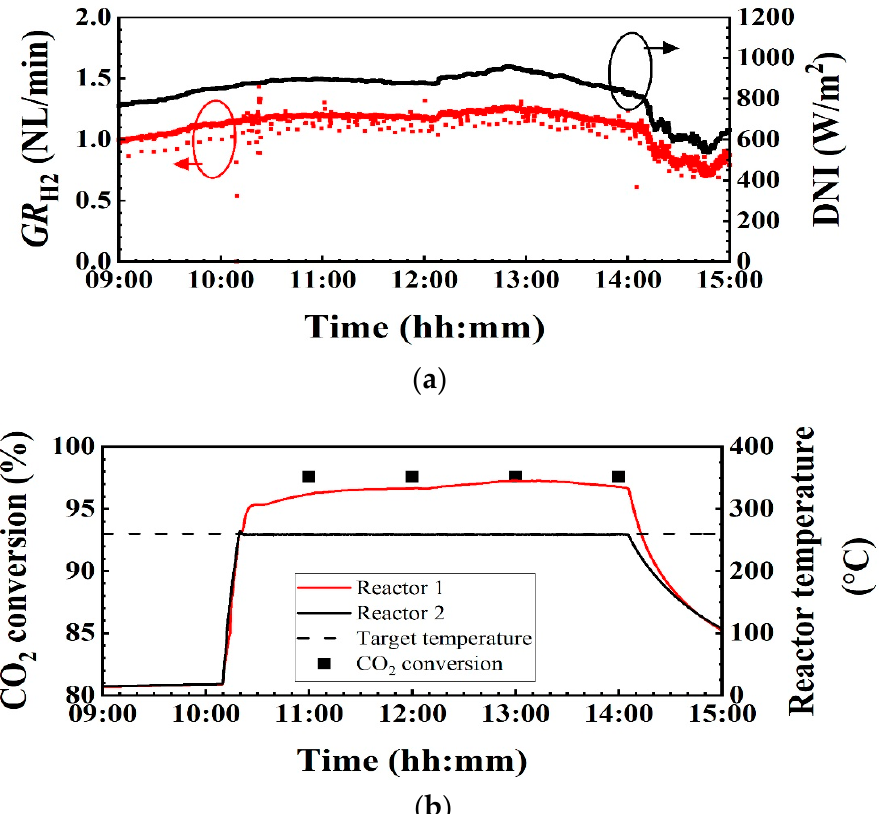
Figure 5. ( a ) Measured hydrogen generation rate ( GR H2 ) compared to direct normal irradiance (DNI) and ( b ) conversion of CO 2 to CH 4 compared to reactor temperature. Data in both plots were obtained on a clear, sunny day (15th November 2019).